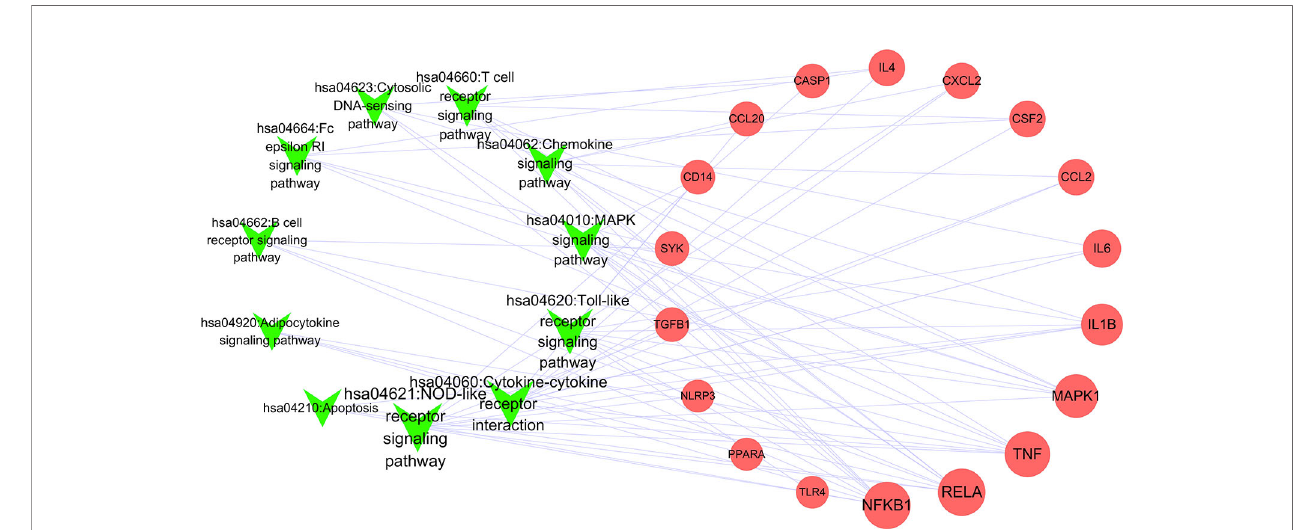
FIGURE 5 | Network of pathways and related genes (Green “ V ” represents pathways; red circle represents pathway; node size represents the degree).